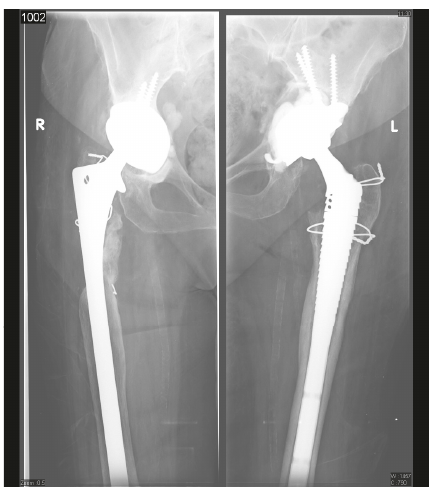
Figure 1: Preoperative A/P left and right hip X-rays of the patient. This figure shows an AP radiograph of the left and right hips of the patient in the immediate preoperative setting.